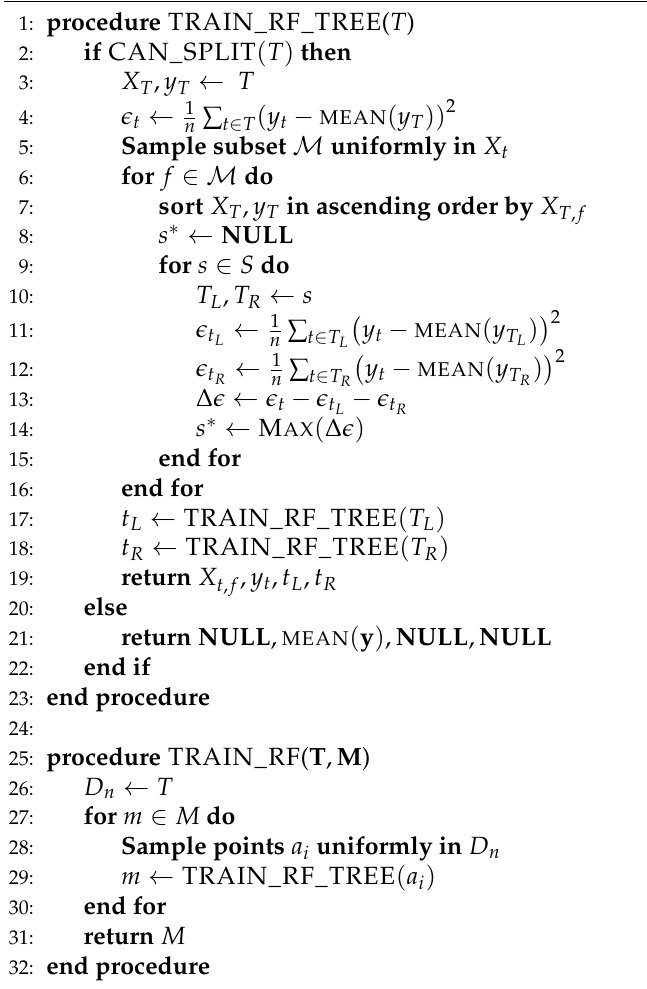
Algorithm 2 Training procedure for Random